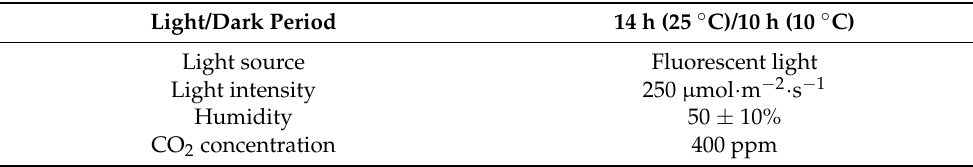
Table 2. Environmental conditions of the phytotron used in this